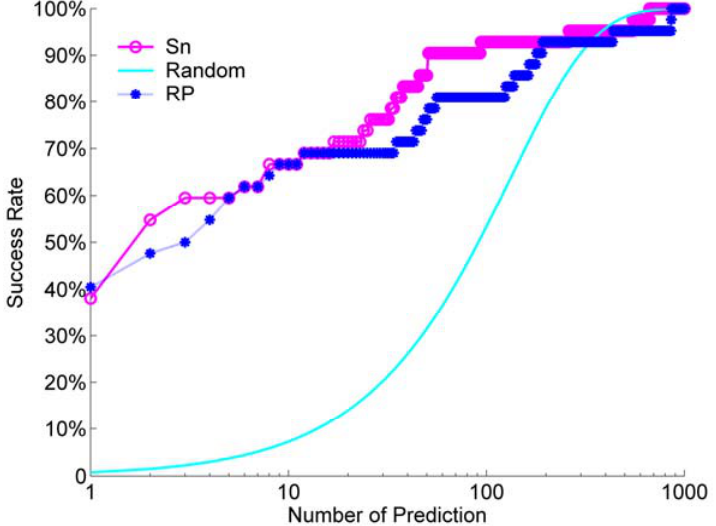
Figure 10. For the bound dock results, the comparison of the success rate between the Sn scoring function, RP scoring function and a random